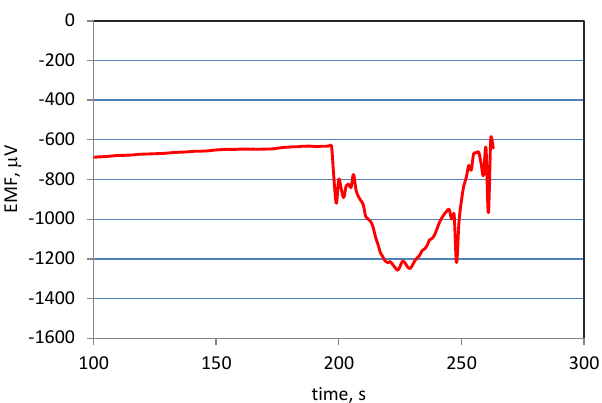
Figure 2. Time profile of measured EMF during a test with BWC bulk and flame from t = 200 to t = 260 s (T 1 = 143.7 ± 2.0 °C, T 2 = 42.5 ± 4.9 °C).